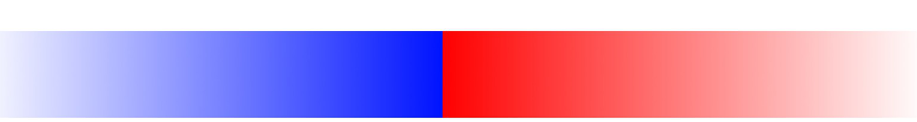
Fig 6. Threshold mapping. A rapid change of the color at the threshold is only hardly possible with the current mapping